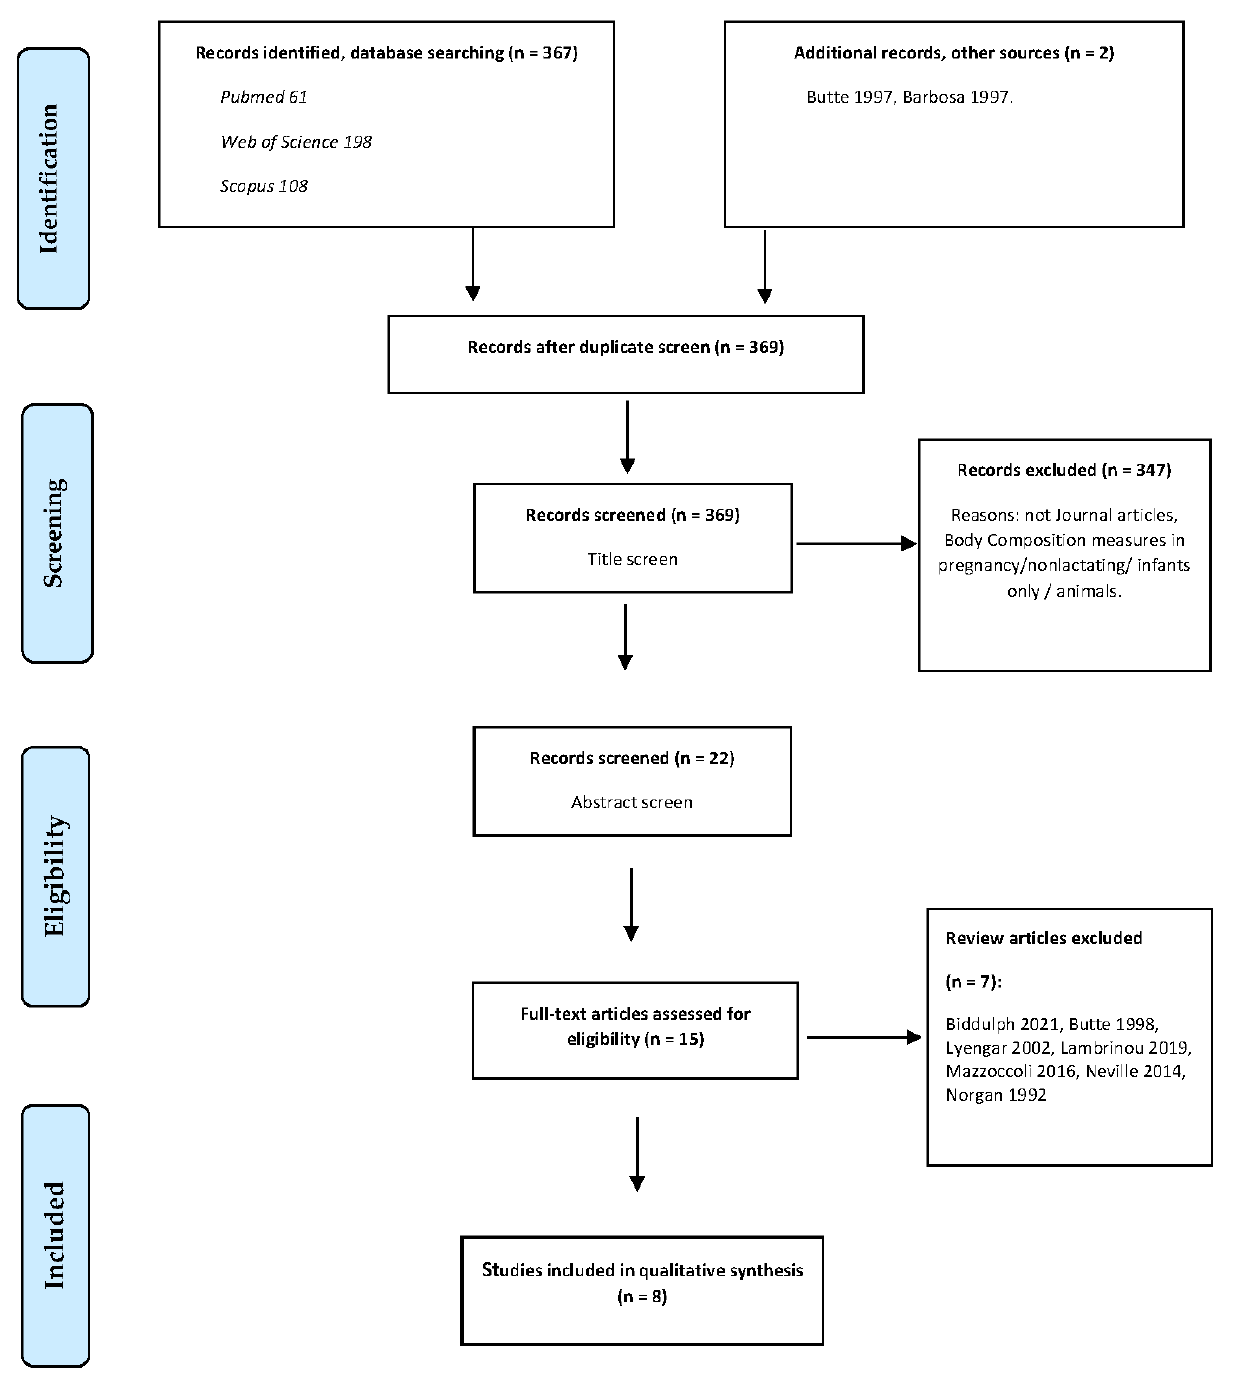
Figure 1. Preferred Reporting Items for Scoping Reviews and Meta-Analyses (PRISMA) flowchart describing study selection